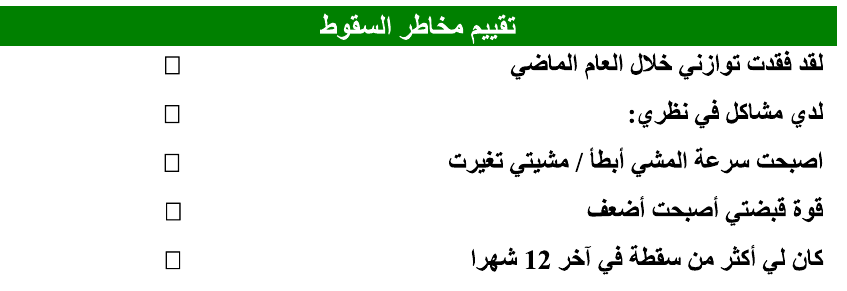
Table 3 Falls risk